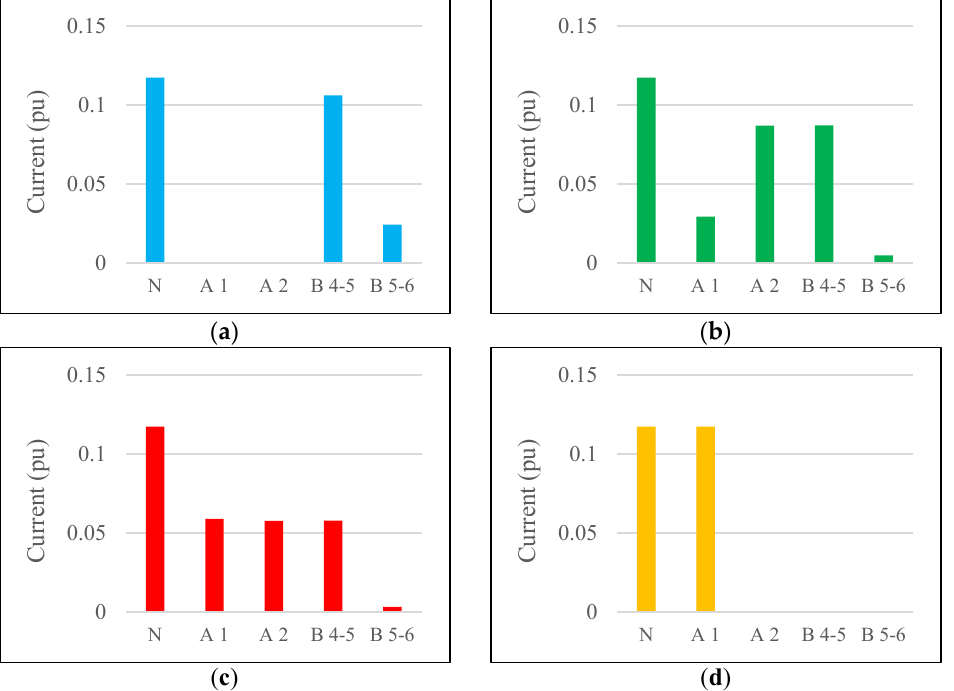
Figure 13. The RMS value of SACAPFs, harmonic content of nonlinear load, harmonic content of B 4-5, and harmonic content of B 5–6 currents. ( a ) Scenario 0; ( b ) Scenario 1; ( c ) Scenario 2; and ( d ) Scenario